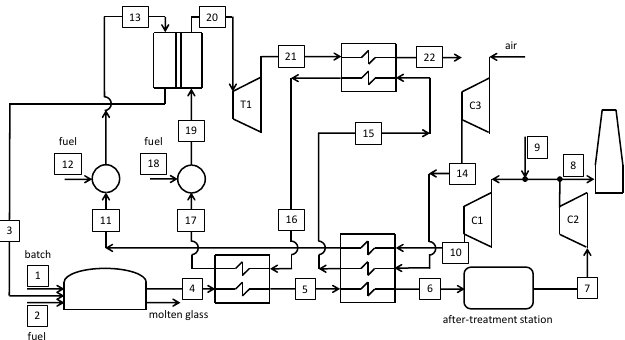
Figure 14. Schematic of the oxy-fuel furnace with integrated 4-end OTM module.